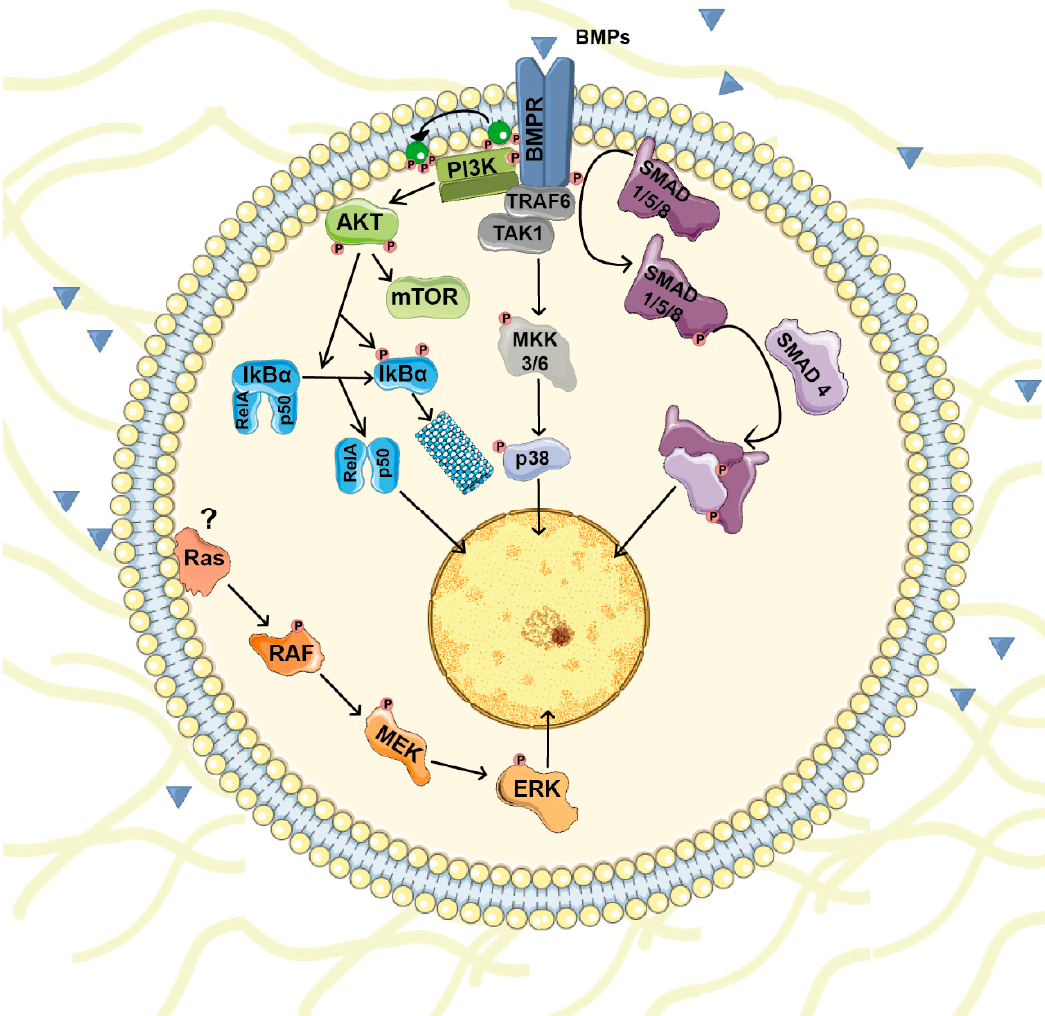
Figure 1. BMP signaling pathways. Once BMP receptors (BMPR) are stimulated they form a complex and initiate an intracellular transduction cascade. In the canonical pathway, BMP receptors phosphorylate and activate the SMAD family of transcription factors that transduce the signal to the nucleus. Besides SMADs, BMPs modulate other intracellular signaling pathways (non-canonical BMP signaling) including PI3K/AKT and various types of MAPKs